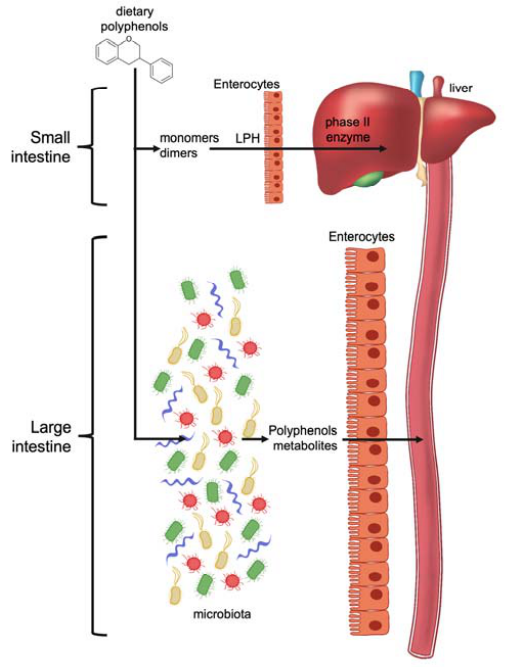
Figure 3. Dietary polyphenol metabolism in small and large intestine. In the small intestine, low molecular weight polyphenols, monomers or dimers, can be absorbed directly or after phase II reaction metabolic conversion. In the large intestine, high molecular weight and conjugated polyphenols are absorbed after transformation processes by enzymes produced by bacteria.